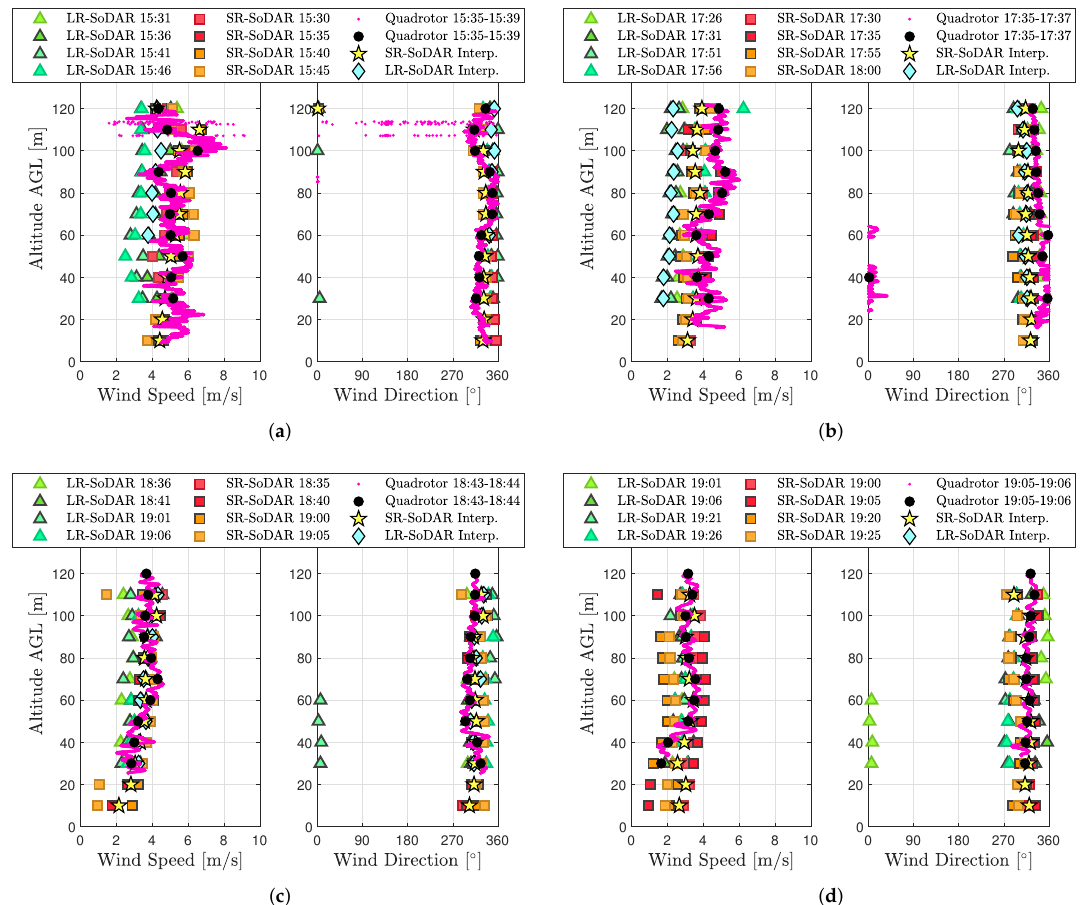
Figure 8. Comparison of wind speed and wind direction profiles from SoDAR and the quadrotor ascending vertically from 10 to 120 m AGL at ( a ) 0.5 m/s, ( b ) 1 m/s, ( c ) 1.5 m/s, and ( d ) 2